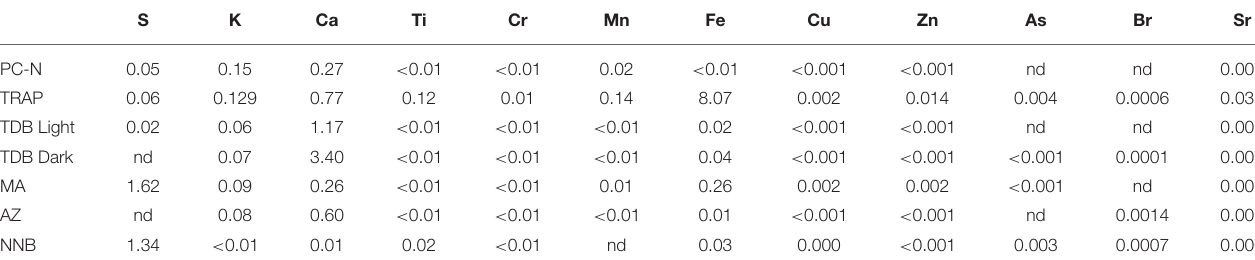
TABLE 4 | Concentrations (weight %) of the elements observed in the PyC samples as determined by XRF (balance C). S